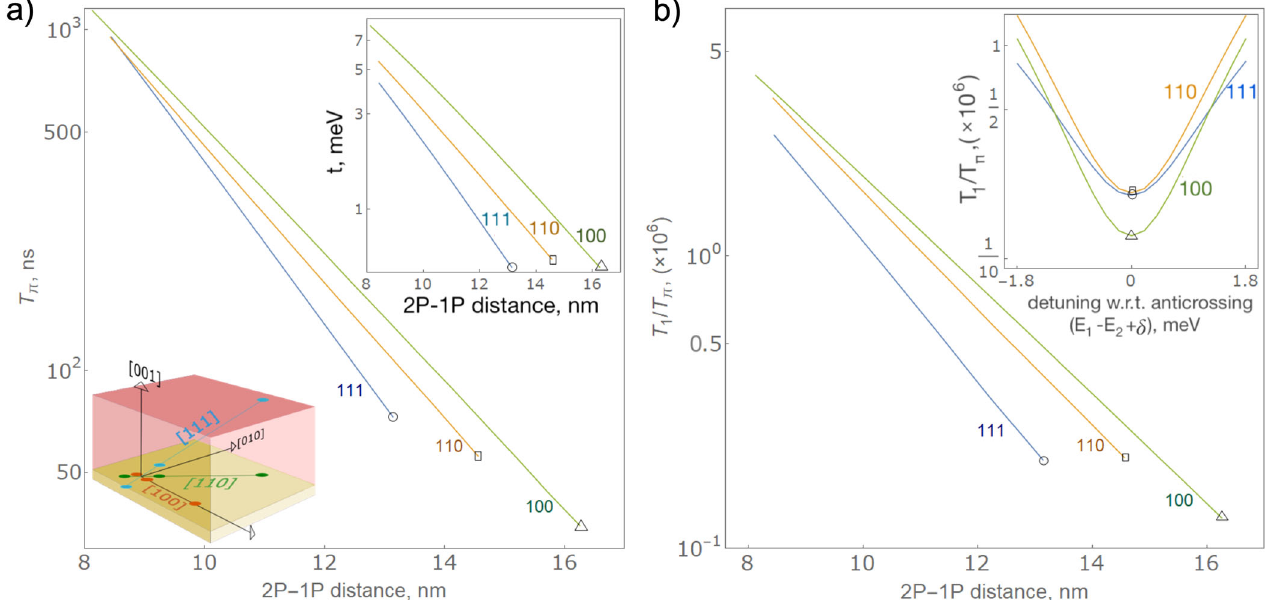
Fig. 3 2P:1P EDSR time T π and Rabi ratio ( T 1 / T π ) vs. 2P-1P separation at the respective anti-crossings for [100] ( − 137 meV), [110] ( − 122.9 meV) and [111] ( − 111.7 meV) qubit orientations. a Variation in EDSR spin- fl ip time with 2P-1P separation. Inset: The difference in tunnel coupling for the three 2P-1P orientations are shown (above). The schematic of the three 2P-1P orientations are shown (below). b Rabi ratio T 1 / T π is shown to highlight the number of spin- fl ip operations possible in a relaxation time. A fi xed B = 1 T magnetic fi eld is applied perpendicular to the plane of qubit orientation giving a Zeeman splitting of 0.116 meV. In all panels, the position of the triangle ([100]), square ([110]) and circle ([111]) mark the 2P-1P separation where our perturbative approach breaks down. Inset: T 1 / T π is plotted against the dc detuning fi eld δ in the vicinity of the